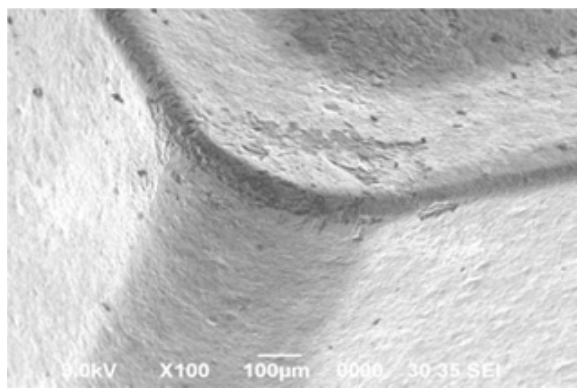
Figure 15. Crater wear at V c D 70 m = min, f D 0:1 mm = rev, and d D 0:3